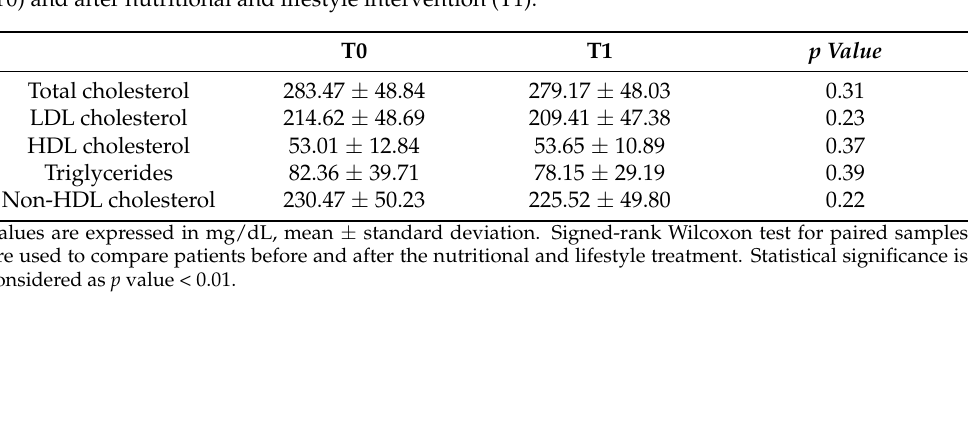
Table 4. Lipid profile of the study population with positive family history for CHD ( n = 66) at baseline (T0) and after nutritional and lifestyle intervention